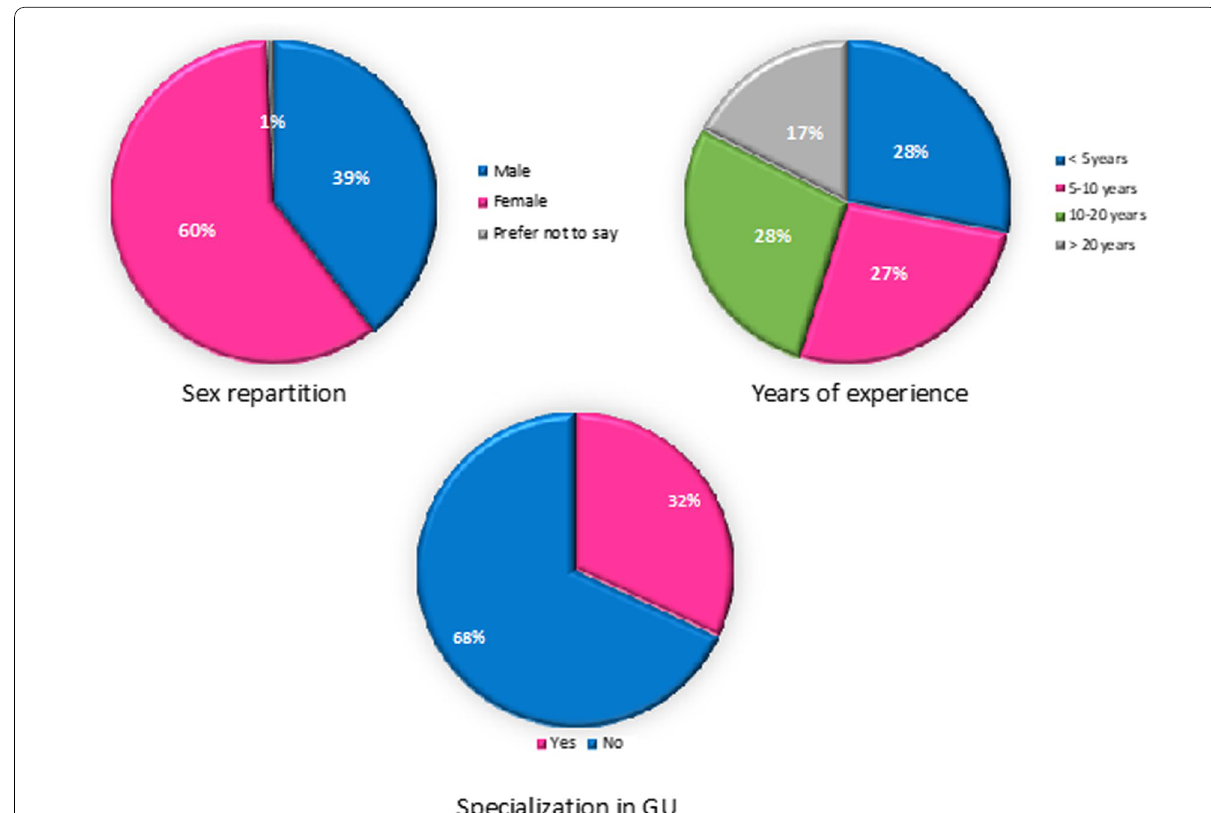
Fig. 1 Overview of the